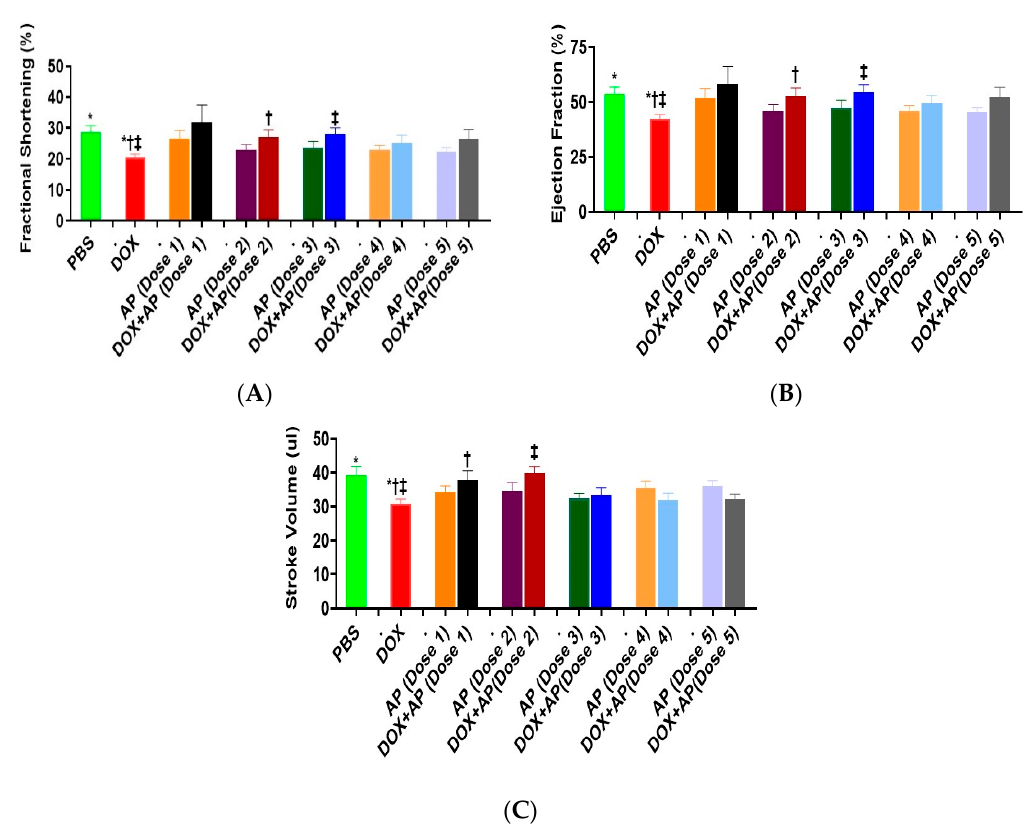
Figure 4. Substance P receptor antagonism significantly attenuates doxorubicin induced cardiac dysfunction; including effects on ( A ) Fractional Shortening ( B ) Ejection Fraction and ( C ) Stroke volume; (A and B; * , PBS vs. DOX; † , DOX + AP (Dose 2) vs. DOX ‡ , DOX + AP (Dose 3) vs. DOX) and (C; * , PBS vs. DOX; † , DOX + AP (Dose1) vs. DOX; ‡ , DOX + AP (Dose 2) vs. DOX) ALL p < 0.05, ANOVA Tukey’s test